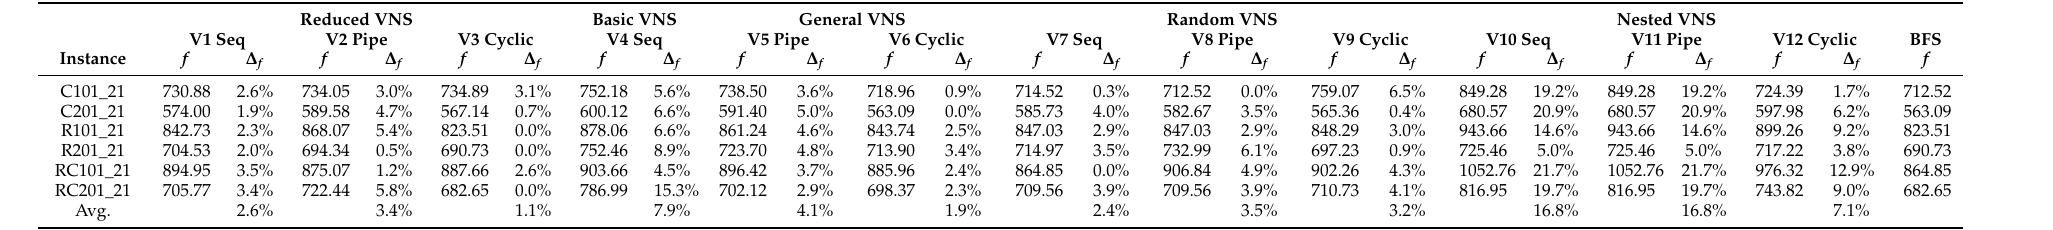
Table 7. Comparison VNS variants results on selected large-sized